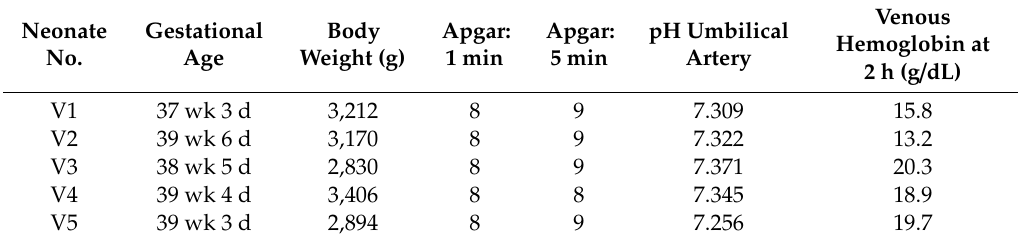
Table 2. Summary of neonates’ clinical data in this